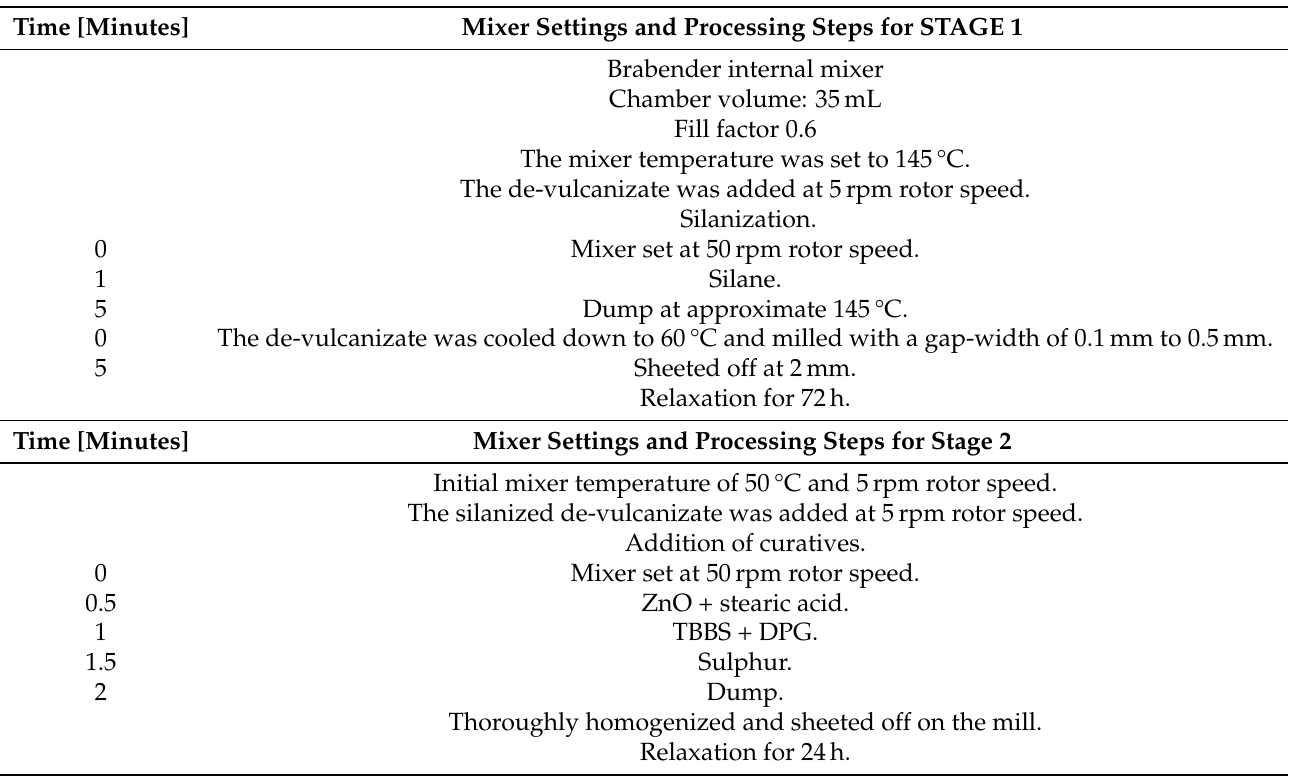
Table A4. Two stage compounding procedure for silica/carbon black based formulations as given in Table A3. Time